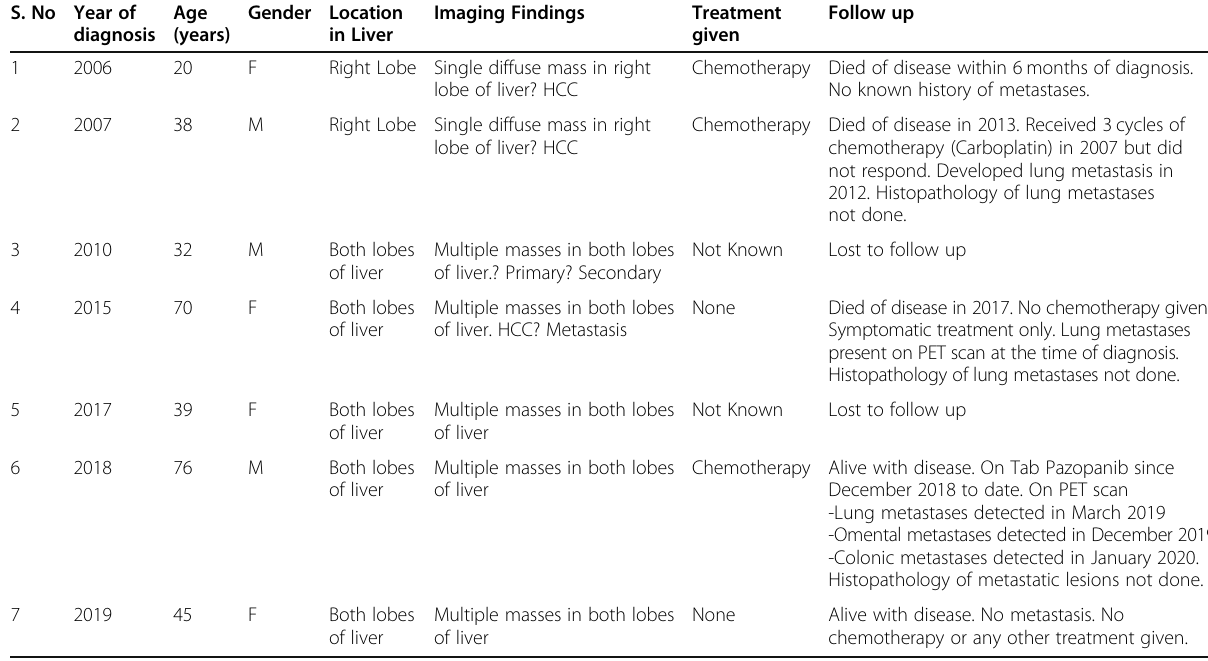
Table 1 Clinical data of Hepatic Hemangioendothelioma HE ( n = 7) S. No Year of Age Gender Location Imaging Findings Treatment diagnosis (years) in Liver